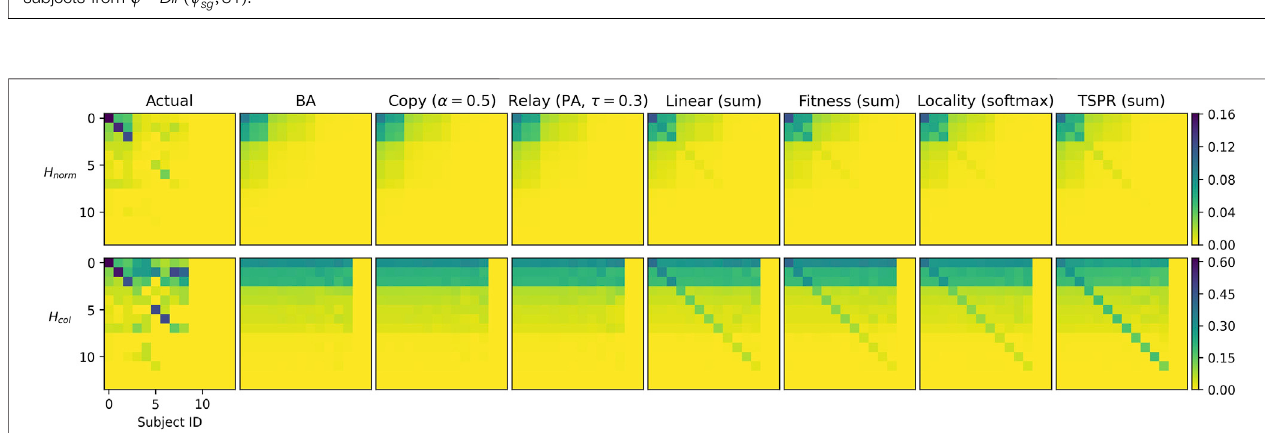
FIGURE 5 | H norm (top row) and H col (bottom row) subject signatures for USSC-calibrated baselines and selected subject models. Subjects are indexed by descending frequency from 0 to 14. Note that color scales differ across rows.